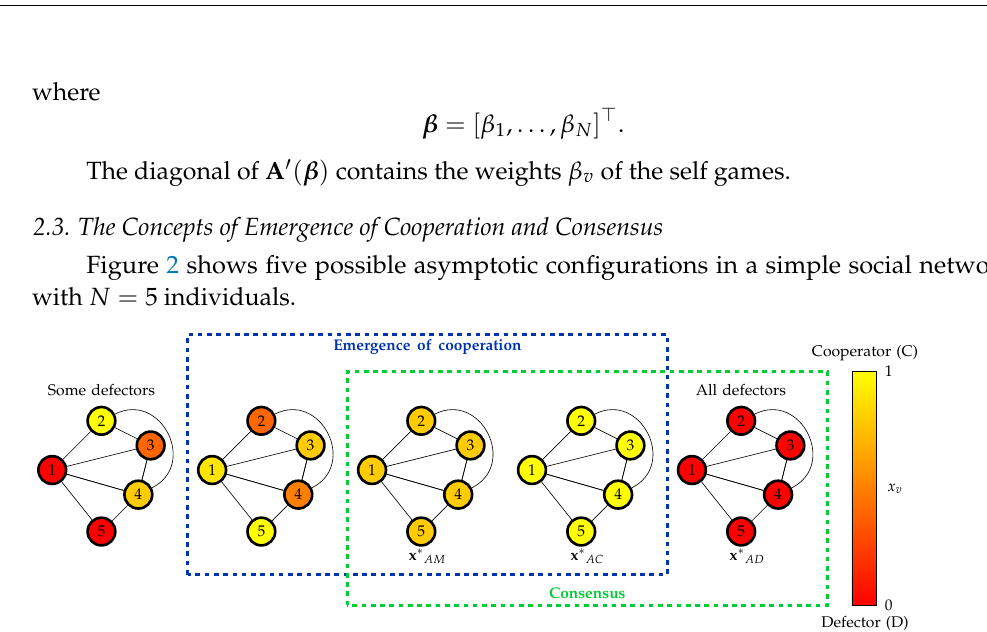
Figure 2. Emergence of cooperation and consensus. Five configurations of a social network of 5 players. The cooperation level of each player is represented by a color ranging from red (full defection, x v = 0) to yellow (full cooperation, x v = 1), as reported on the shaded box on the rightmost part of the figure. The first graph shows a generic configuration with cooperators, defectors and mixed players. The graphs highlighted by the blue dashed line box, are examples of emergence of cooperation, since no full defector is present. In particular, the middle graph corresponds to the steady state x ∗ AM , while the last one represents the steady state x ∗ AC . The fifth graph shows a population composed of full defectors only, thus SR-EGN converged to the steady state x ∗ AD . The graphs in the green dashed line box represent consensus states, since all players reach the same level of